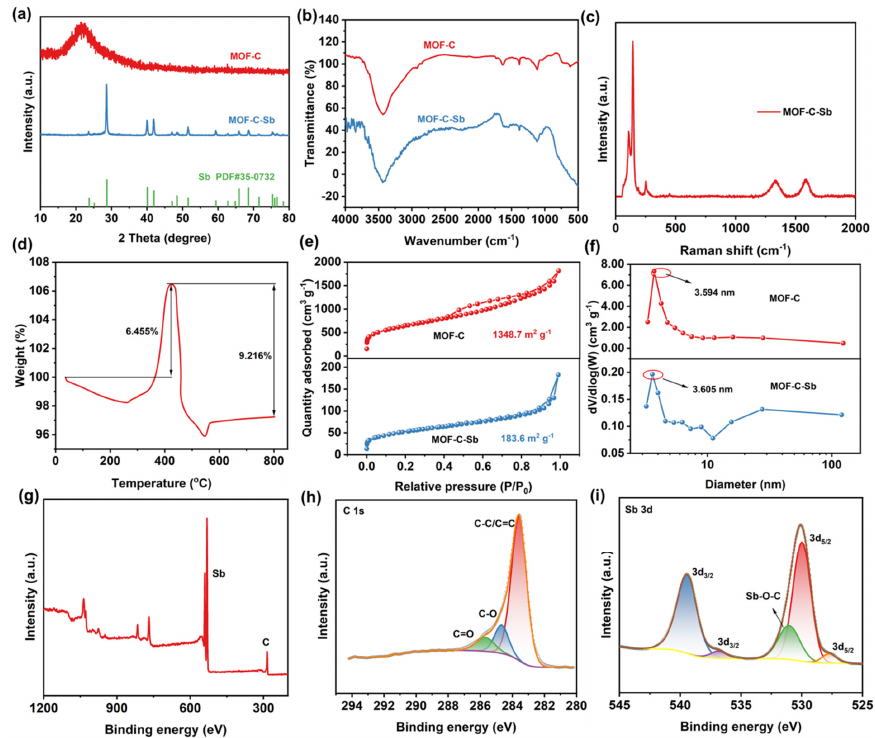
Figure 2. ( a ) The XRD patterns, ( b ) FTIR spectroscopy, ( c ) Raman curves, ( d ) TGA curves, ( e ) N 2 adsorption − desorption isotherms, ( f ) pore size distributions, and ( g ) XPS survey spectra of the materials. High − resolution XPS spectra of C 1s ( h ) and Sb 3d ( i ) of MOF − C − Sb. Nanomaterials 2023 , 13 , 254 Figure 3a–c shows scanning electron microscopy (SEM) images of MOF ‐ C–Sb; it can be observed that it exhibits cubic particles with a size of approximately 10 μ m. Figure 3d displays a surface scan region of an energy ‐ dispersive X ‐ ray (EDX) image, and the presence of the three elements Sb, C, and O can be clearly observed in Figure 3e. Further, the elemental mappings of MOF ‐ C–Sb confirm the uniform distribution of the three elements Sb, C, and O (Figure 3f). As shown in Figure 4a,b, the SEM images of pure Sb reveal a small granular spherical morphology. Figure 4c shows transmission electron microscopy (TEM) image of pure Sb, exhibiting a small granular spherical morphology, which is consistent with the SEM results. Regarding the TEM image of MOF ‐ C–Sb as shown in Figure 4d, the darker areas within the small red circles are metallic Sb, implying the homogeneous encapsulation of Sb. High ‐ resolution TEM (HRTEM) imagery exhibits a lattice spacing of 0.32 nm for MOF ‐ C–Sb, corresponding to the (221) plane of Sb [7]. In addition, as displayed in Figure 4f, the selected ‐ area electron diffraction (SAED) pattern shows the three main visible diffraction rings of Sb, further demonstrating the successful introduction of Sb.